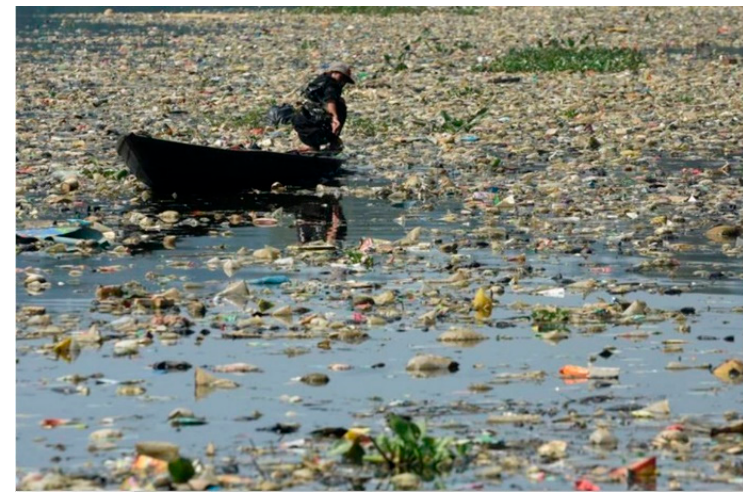
Figure A7. Stimulus Image for the Water Contamination Message.